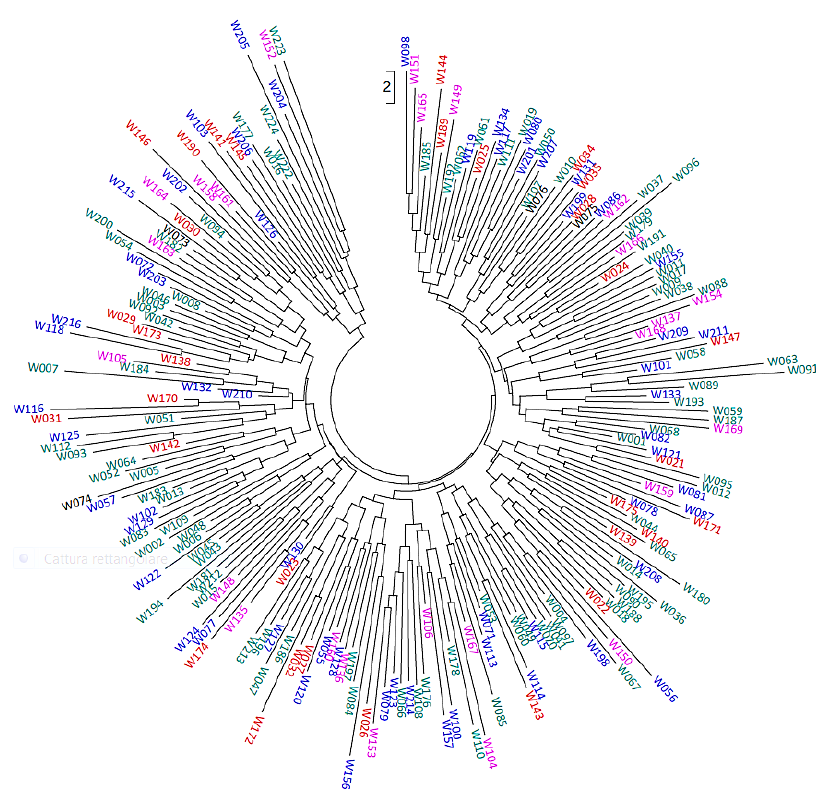
Figure 2. UPGMA (Unweighted Pair Group Method with Arithmetic Mean) ‐ based circular dendrogram showing genetic similarities between the 215 walnut ( Juglans regia L.) accessions analyzed as listed in the supplementary material, Table S1. Accessions from the same geographic area have the same color (see the legend in Figure 1B for association of the colors with the geographical areas). Table 3. Analysis of Molecular Variance (AMOVA) of five walnut populations analyzed with 20 SSRs.